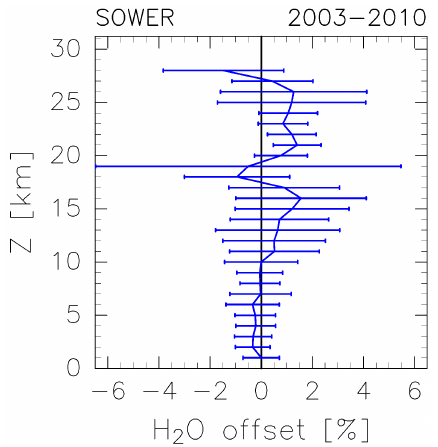
Figure 8. As for Fig. 4 but for water vapor partial pressure and mixing ratio.